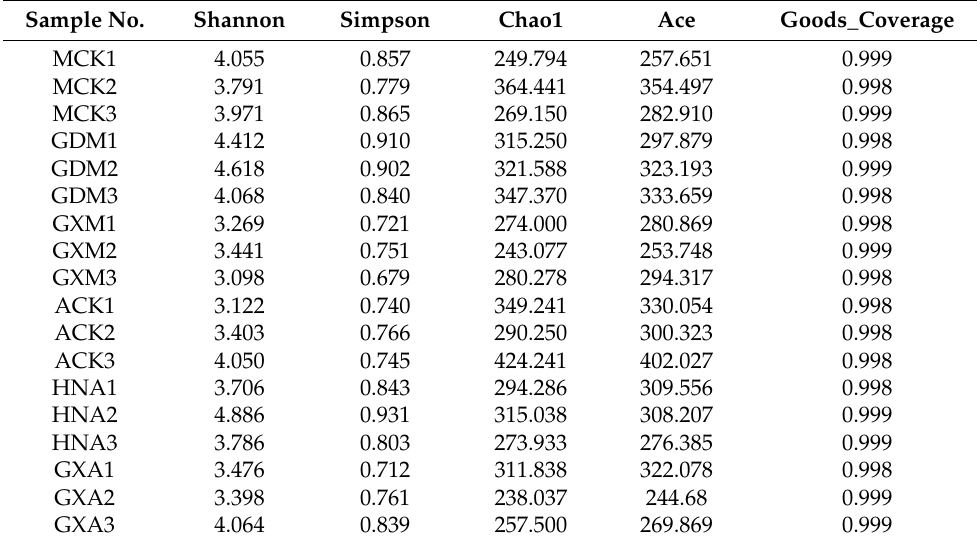
Table 2. Alpha-diversity indices of